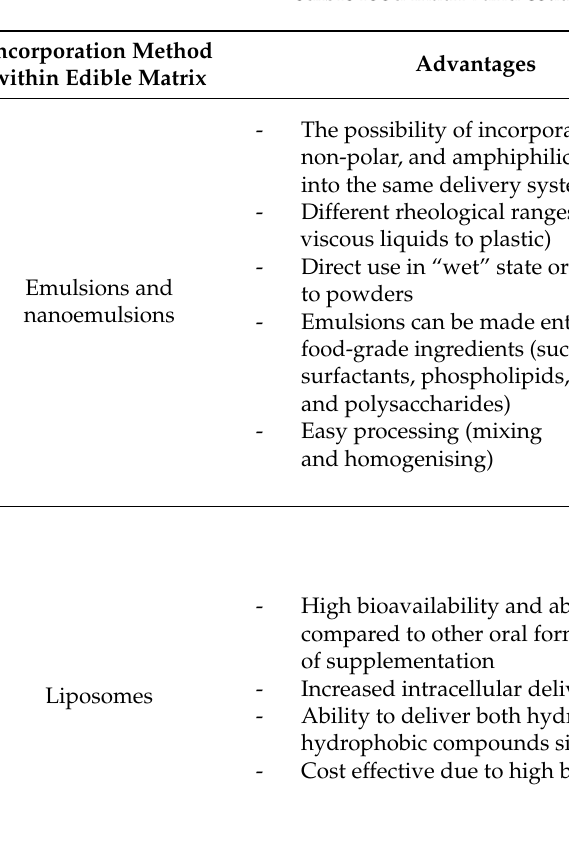
Table 3. Examples of the most common incorporation methods of bioactive ingredients within the edible food matrix and